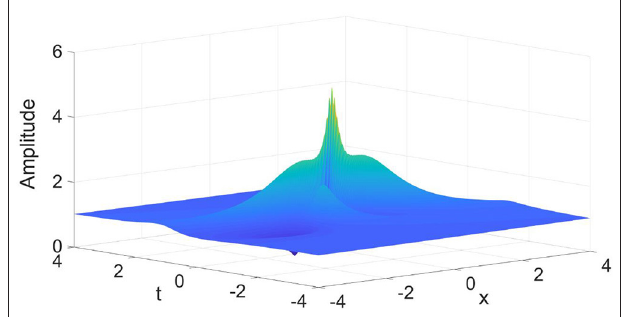
FIGURE 9 | The amplitude of the normalized second-order rogue wave of the complex valued wave envelope u governed by a nonlinear Schrödinger equation with quintic nonlinearity, Equation (8). There is a central maximum with two smaller peaks on the sides.